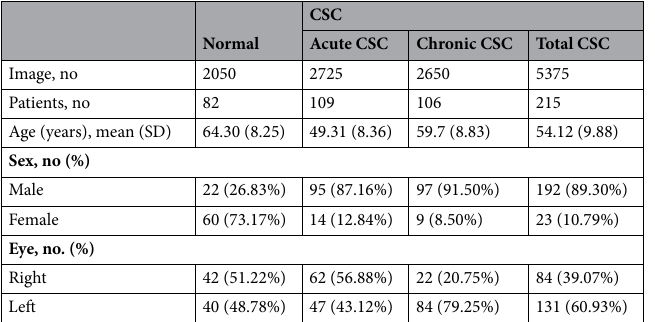
Table 1. Baseline characteristics of patients who had undergone macular OCT. OCT optical coherence tomography, CSC central serous chorioretinopathy, SD standard deviation.